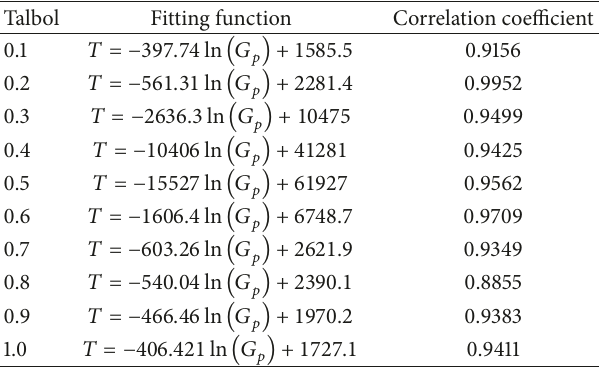
Table 3: Functional relationship of seepage instable duration with pressure gradient and their correlation